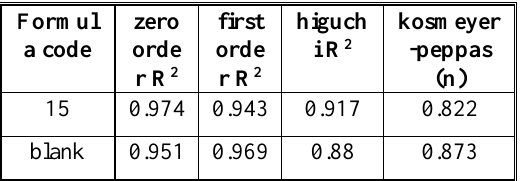
Table 9. In vitro release kinetics of AC hydrogel formulas